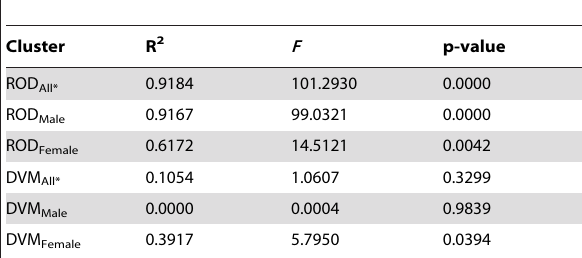
Table 2. Results from linear regression of fraction of days white sharks engaged in diving behaviors over distance (degrees of longitude) from the center of the Cafe´.